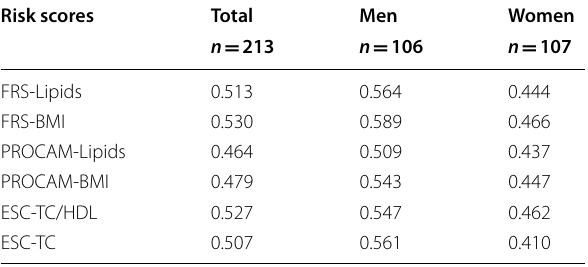
rank correlation between cardiovascular risk scores and carotid intima– media thickness ( P < 0.001 for each correlation)